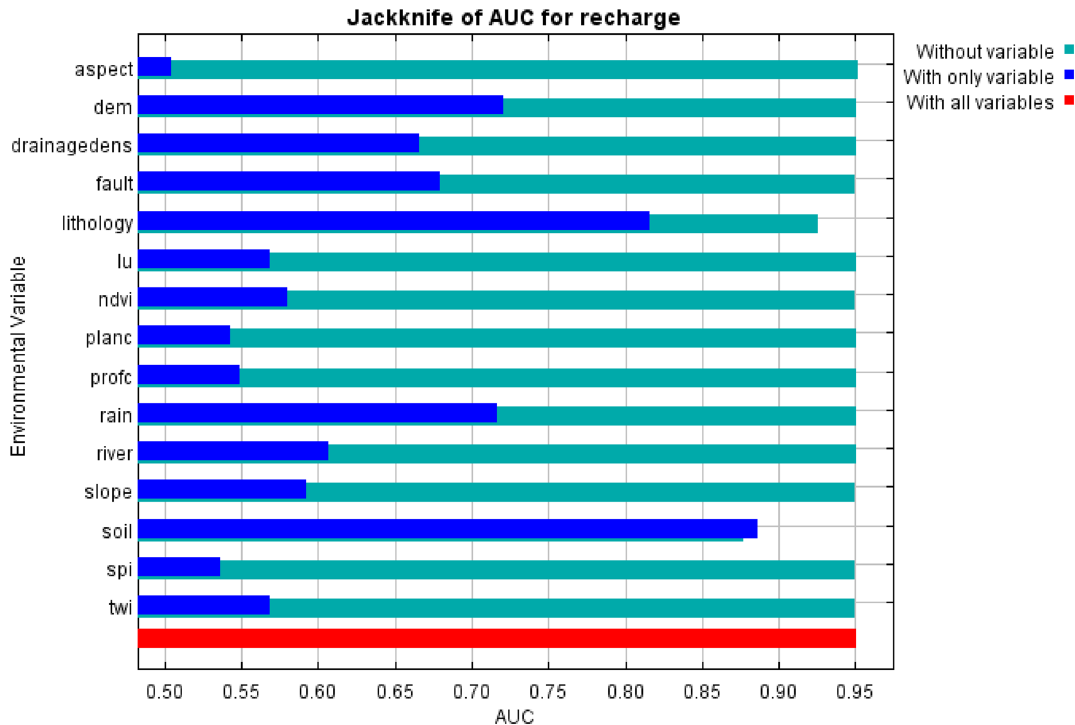
Figure 5. The Jackknife of regularized gain for GWR potential zones in Marboreh